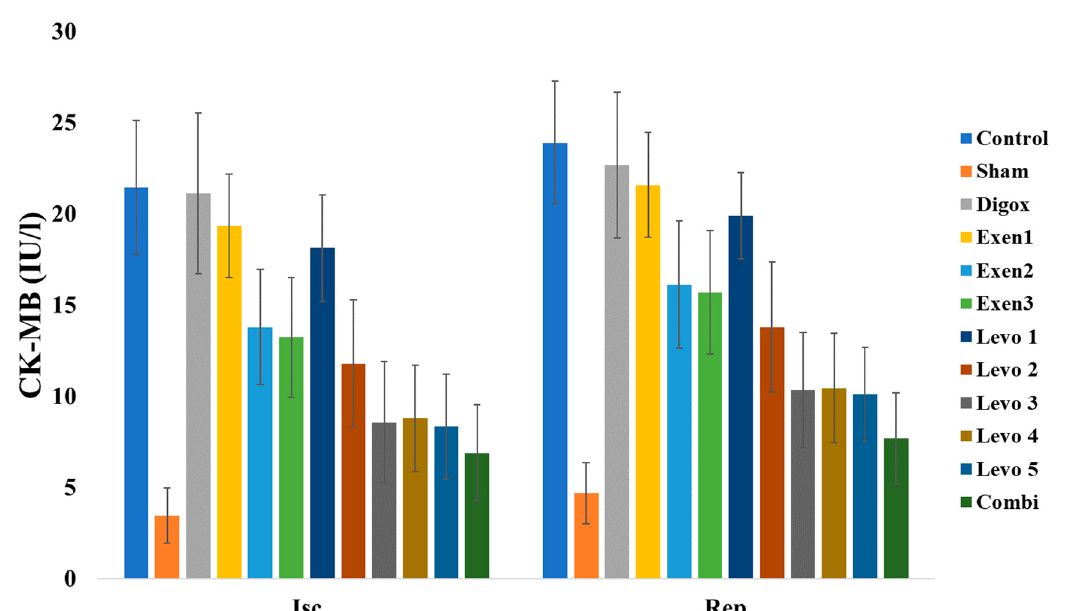
Table 13. Longitudinal analysis for LDH for all groups.